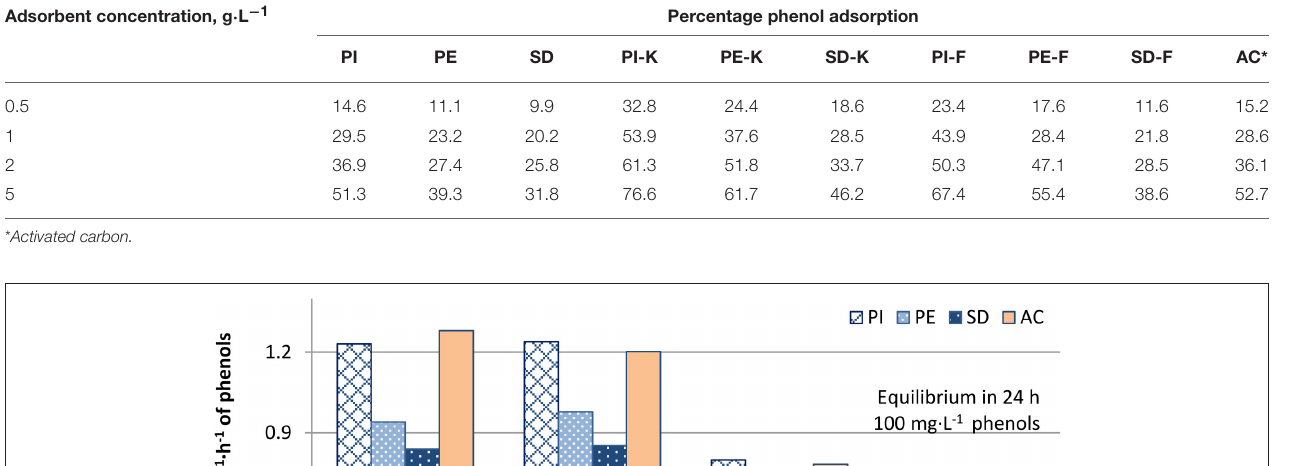
TABLE 4 | Percentage phenol adsorption on biochars PI, PE, SD and modified biochars PI-K, PE-K, SD-K or PI-F, PE-F, SD-F for various adsorbent concentrations (0.5, 1, 2, and 5 g · L − 1 ). Adsorbent concentration, g · L − 1